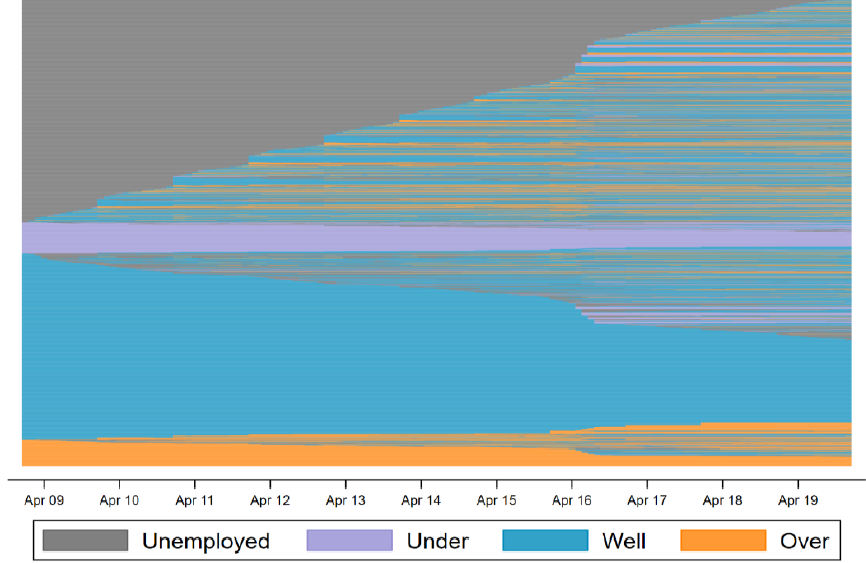
Figure 1. Educational mismatch trajectories map, 2009–2019.